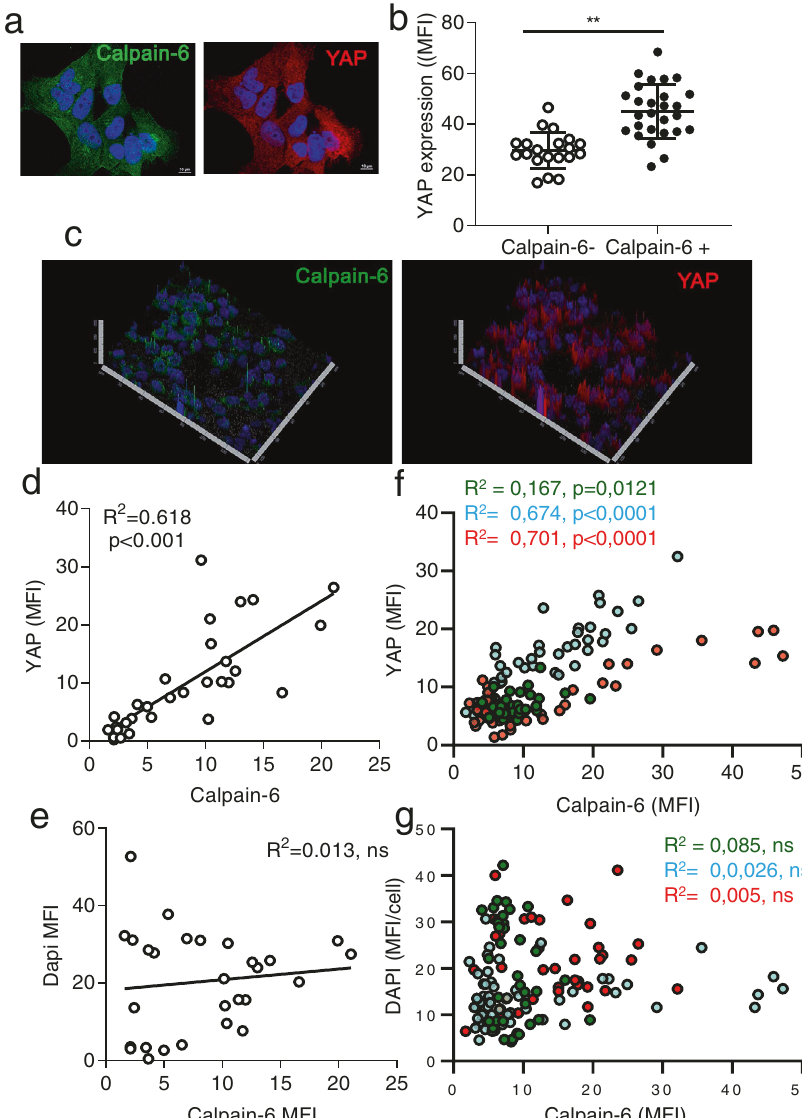
Fig. 3 YAP accumulates in calpain-6 – expressing cells and tumors. a Representative immuno fl uorescence of calpain-6 (green) and YAP (red) in cultured 143B cells. DAPI (blue) staining indicates nuclei. Green arrow indicates calpain-6 and corresponding YAP labeling in the same cell. b Mean ± SEM fl uorescence intensity (MFI) of YAP labeling in cells without calpain-6 (Calpain-6-) and in calpain-6 – expressing cells (Calpain- 6 + ). c Representative 3D view of calpain-6 (green) and YAP (red) labeling in a section of 143B cell-derived bone tumor in mouse. d , e , Correlations between Calpain-6 and YAP ( d ) or DAPI ( e ) staining in cells of the mouse tumor section. f , g , Correlations between Calpain-6 and YAP ( f ) or DAPI ( g ) staining in cells of tumor sections from paraf fi n-embedded lung metastatic tissue from osteosarcoma patients. The colors of the different dots distinguish cells of tissue sections from 3 different